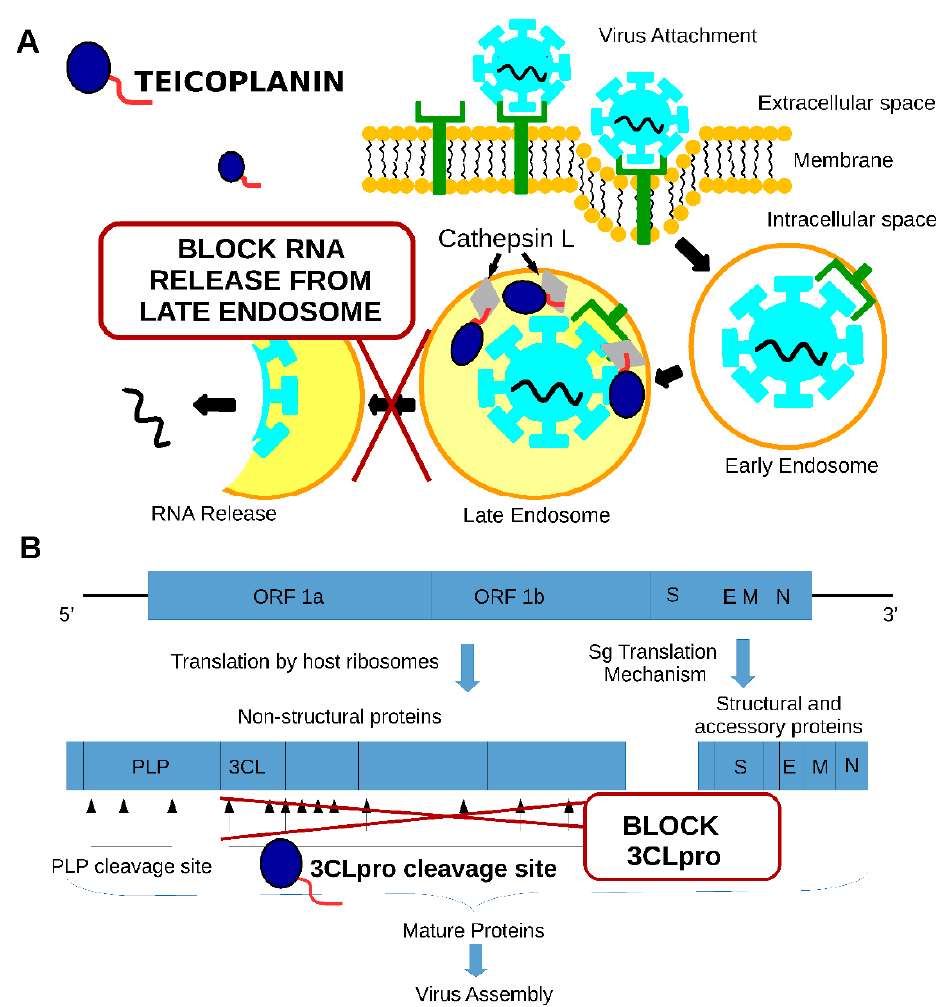
Figure 3. Two mechanisms that have been proposed for teicoplanin anti-SARS-CoV activity: ( A )— inhibition of cathepsin L activity, ( B )—inhibition of 3CLpro activity. ( A )—inhibition of cathepsin L activity, ( B )—inhibition of 3CLpro activity. 8. Bacterial Co-Infections in COVID-19 Patients and the Potential of Teicoplanin